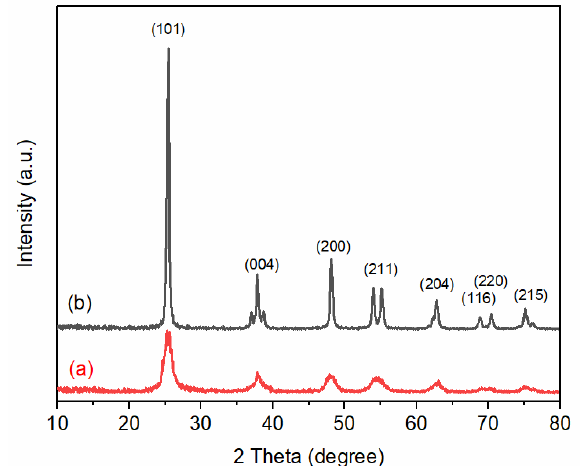
/C and (b) N-TiO /C(500) 2 2